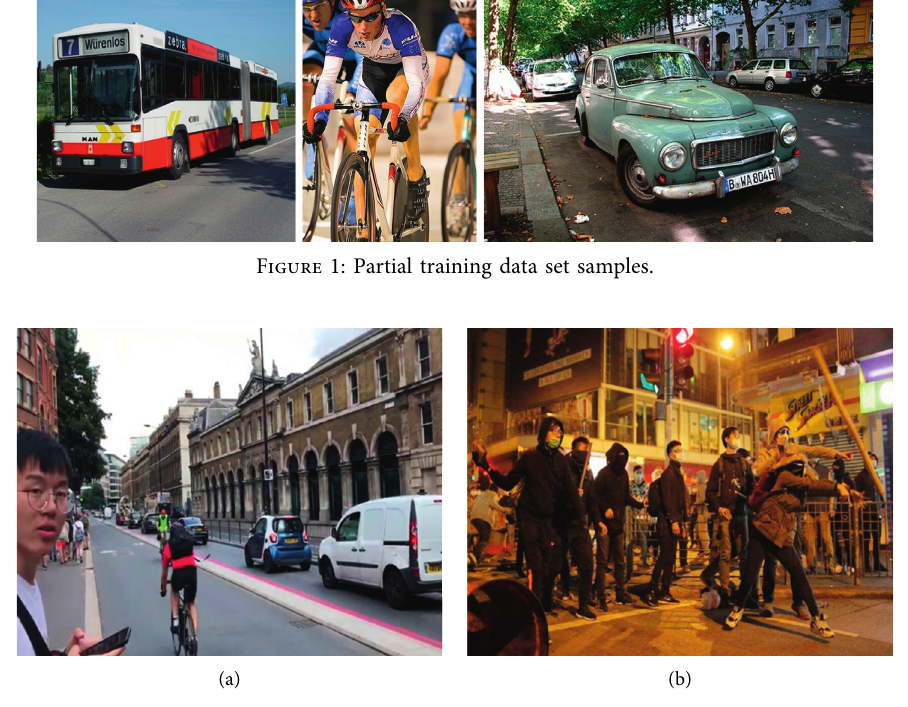
Figure 2: Some test set data samples. (a) Normal state. (b) Abnormal